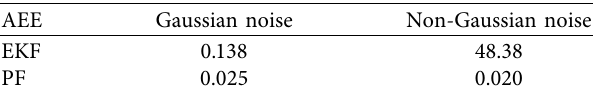
Table 17: AEE for one landmark.